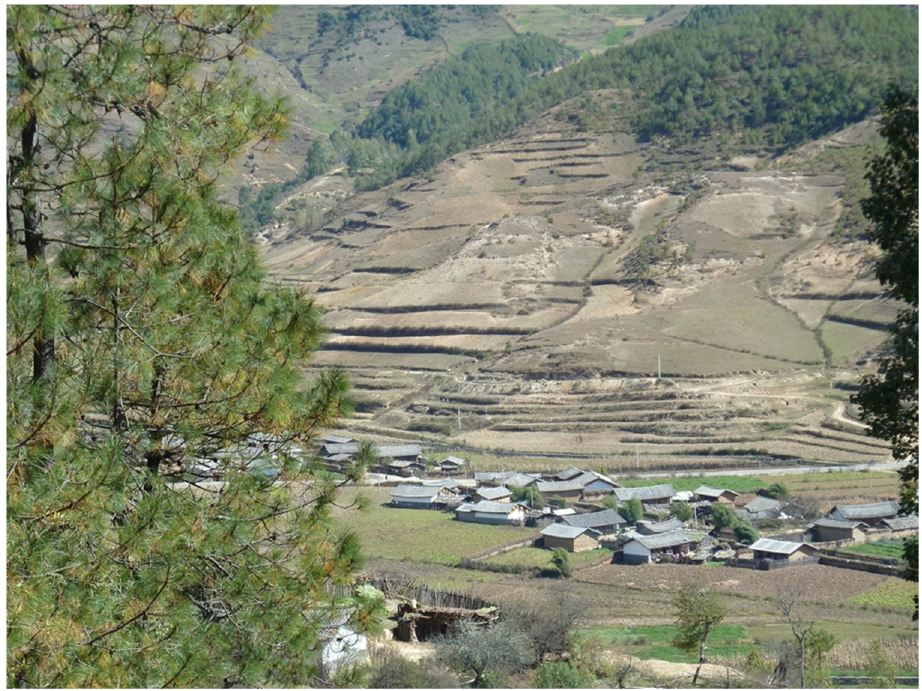
Figure 1. An upland mountainside cleared for swidden agriculture in Niplat, 2011. Photograph by the author.